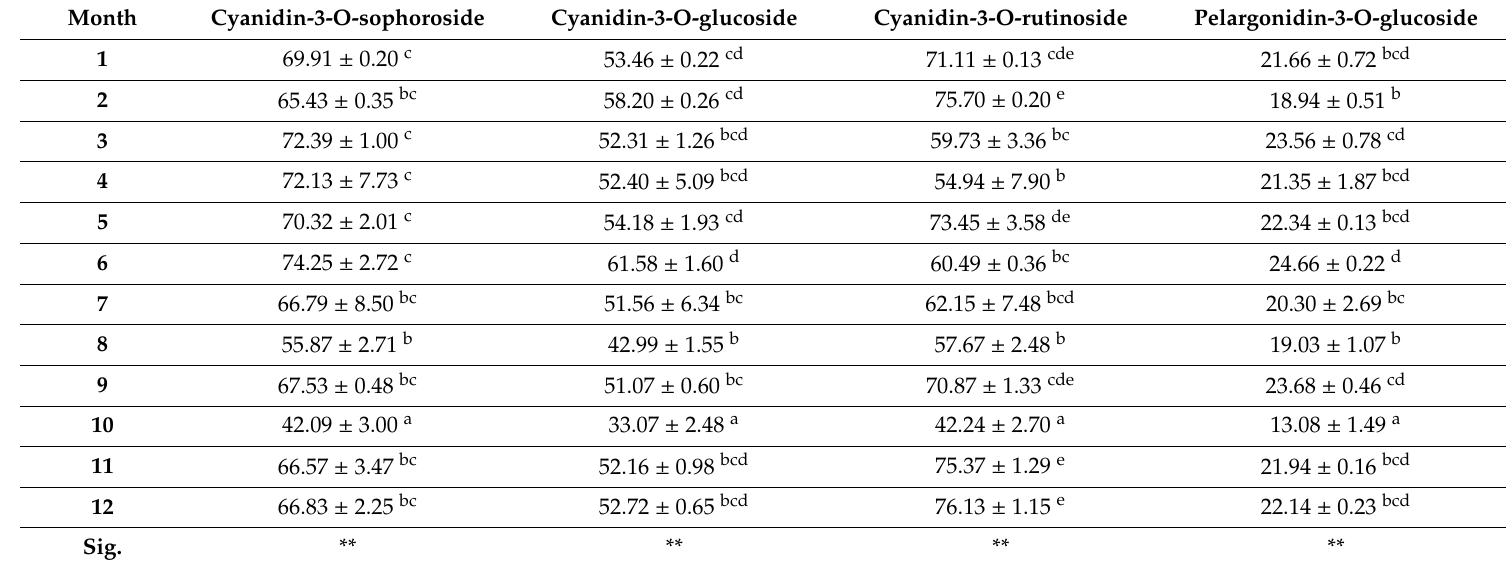
Table 17. Fruits stored at –20 ◦ C in freezer, packaged in Nanoactive B film. E ff ect of storage period on the di ff erent anthocyanidin compounds content in red raspberries (cv. Erika). Results are expressed in µ g / g of fresh weight. The results are the mean of three replicates ± Standard Deviation. ** ( P ≤ 0.01). The letters represent the significant di ff erence vertically at P ≤ 0.05.